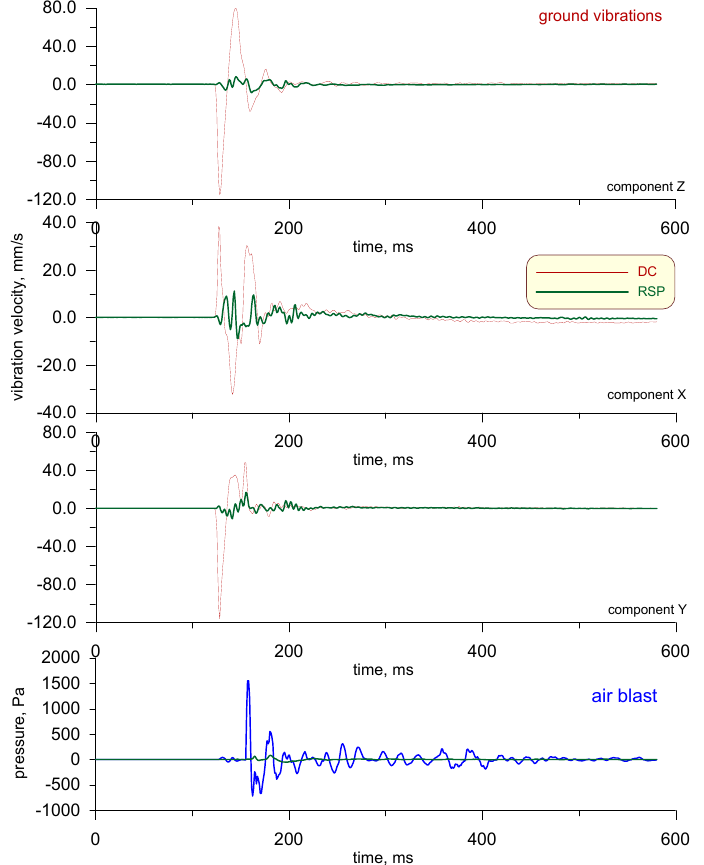
Figure 10. Comparison of vibration seismograms and PFU records at station of 1.